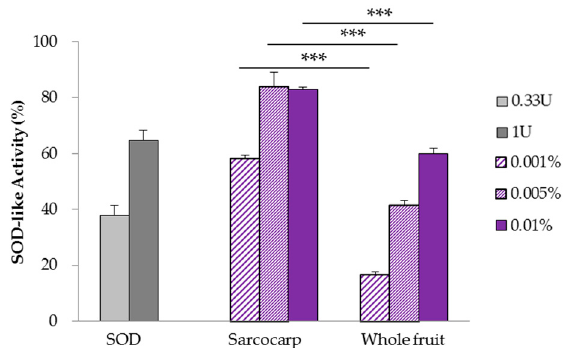
Figure 2. SOD-like activity in the aqueous extracts from C. sinensis . Equal quantities of sarcocarp and whole fruit extracts were dissolved in distilled water to the appropriate concentration, and the SOD-like activity was determined. The sample concentration is described as the solid concentration. Results are expressed as the mean ± SD (n = 3) (*** p < 0.001).